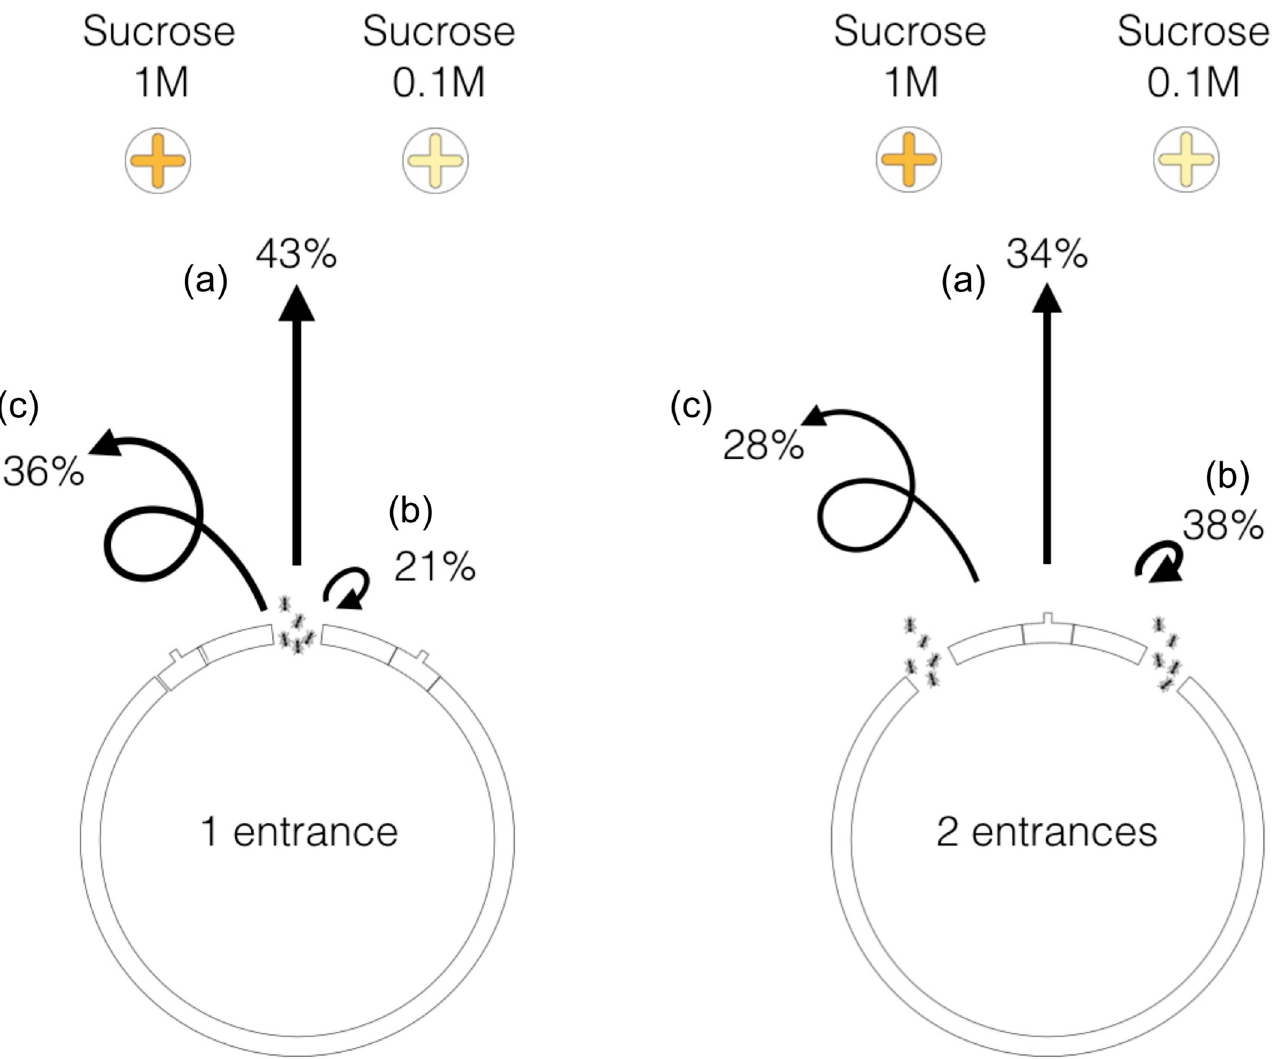
Fig 4. Influence of the nest entrance configuration on the ant’s journey outside the nest. Proportion of ants reaching any food source (a), going back to the nest (b) or remaining in the arena (c) after 3 minutes of observation (n = 140 for one-entrance nests, and n = 280 for two-entrance nests).